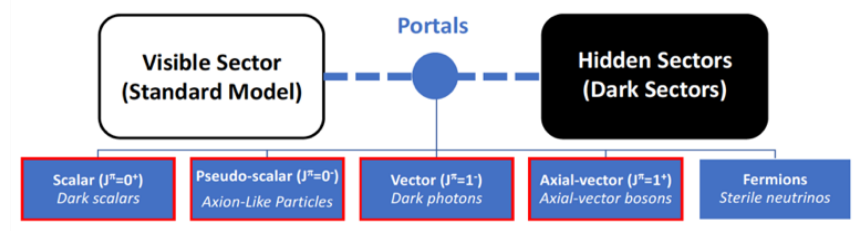
Figure 1. Illustration of the Standard Model coupling to Dark Sectors through given portals. Portals that might be studied though nuclear physics experiments are indicated with a red